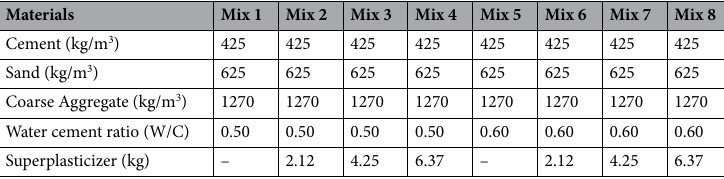
Table 7. Trials batches of